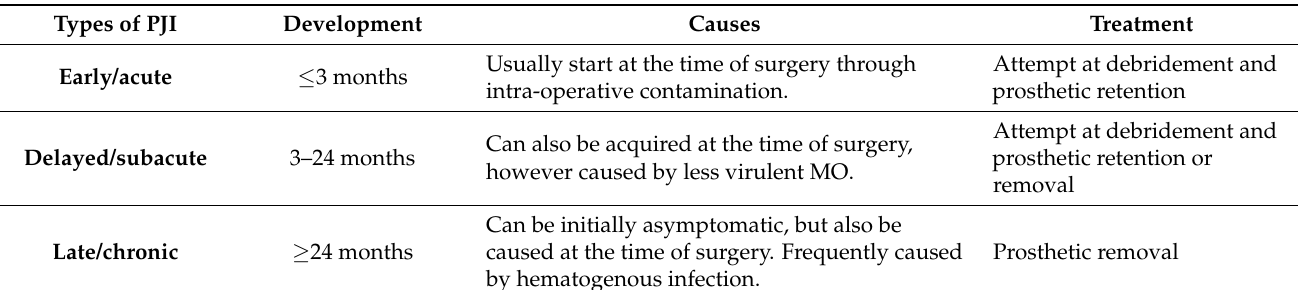
Table 1. Types of periprosthetic joint